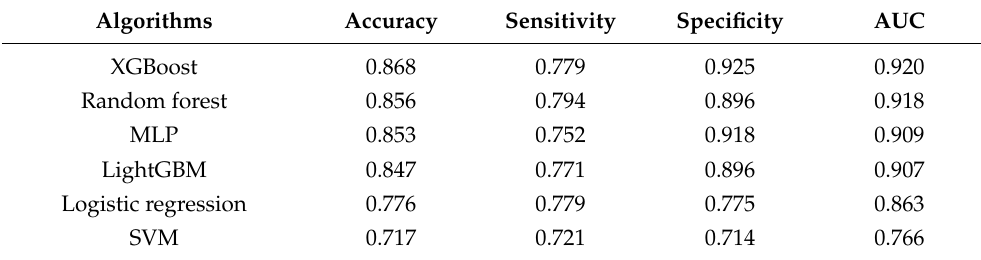
Figure 4. The ROC curve of the acute respiratory failure models. Table 4. Model results: acute hepatitis.